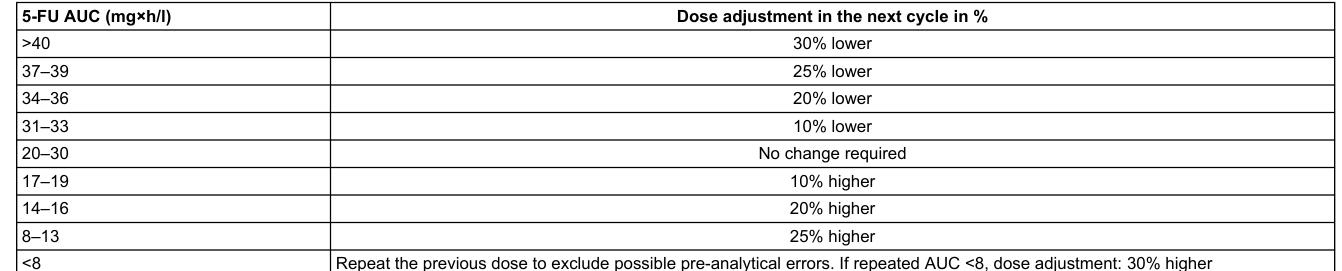
Table 4: 5-fluorouracil TDM dosing scheme. 5-FU AUC